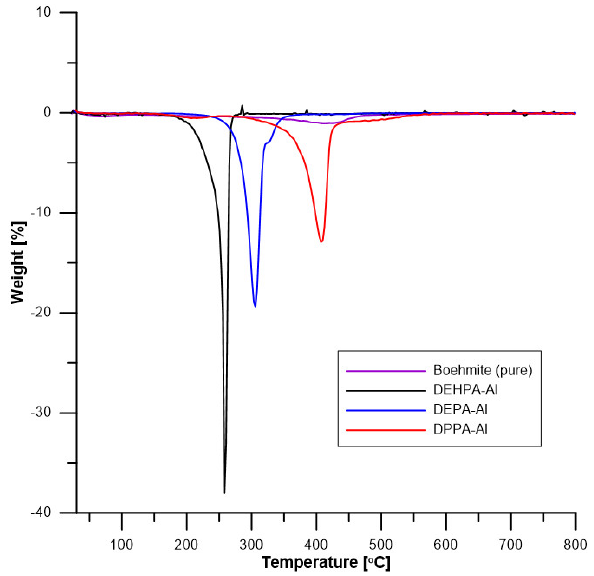
Figure 7. DTG curves of boehmite and hybrids (in helium).